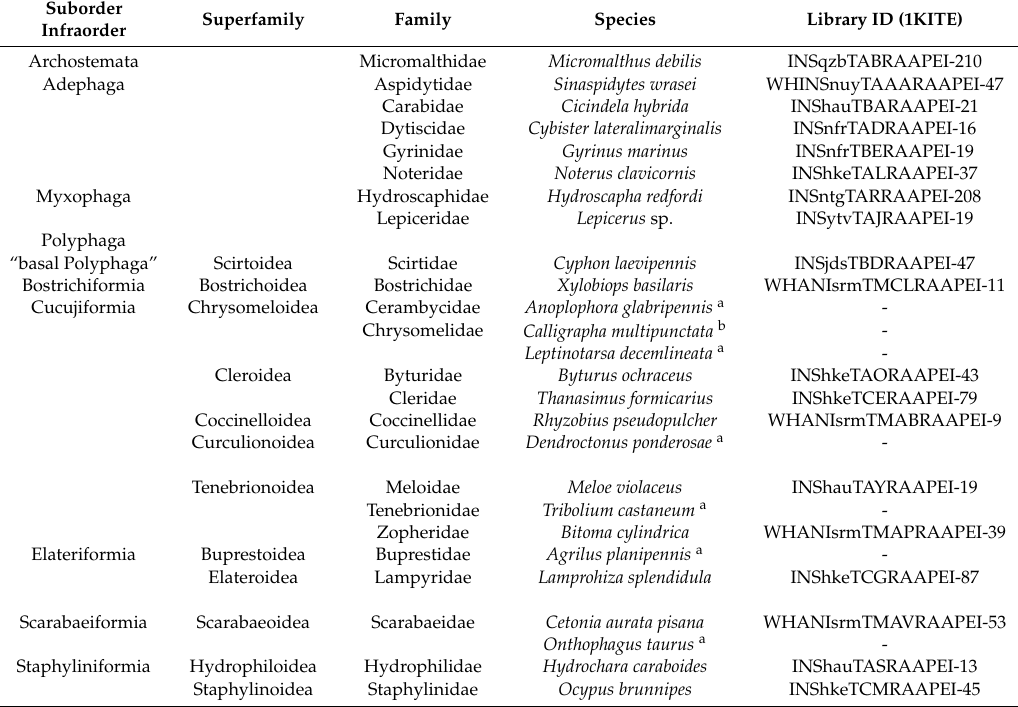
Table 2. Beetle species used in the current study and their current systematic placement. Unless specified otherwise, gene sequence data were obtained from